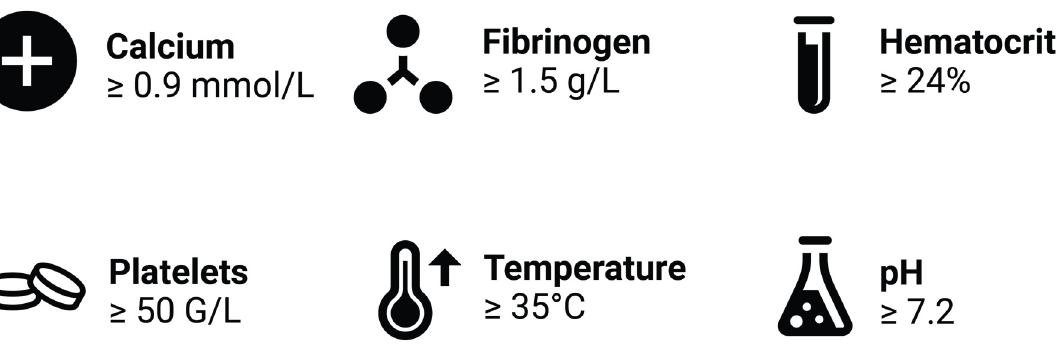
Figure 1. Recommended preconditions of hemostasis, as described by Kozek-Langenecker et al. [11] and Spahn et al.